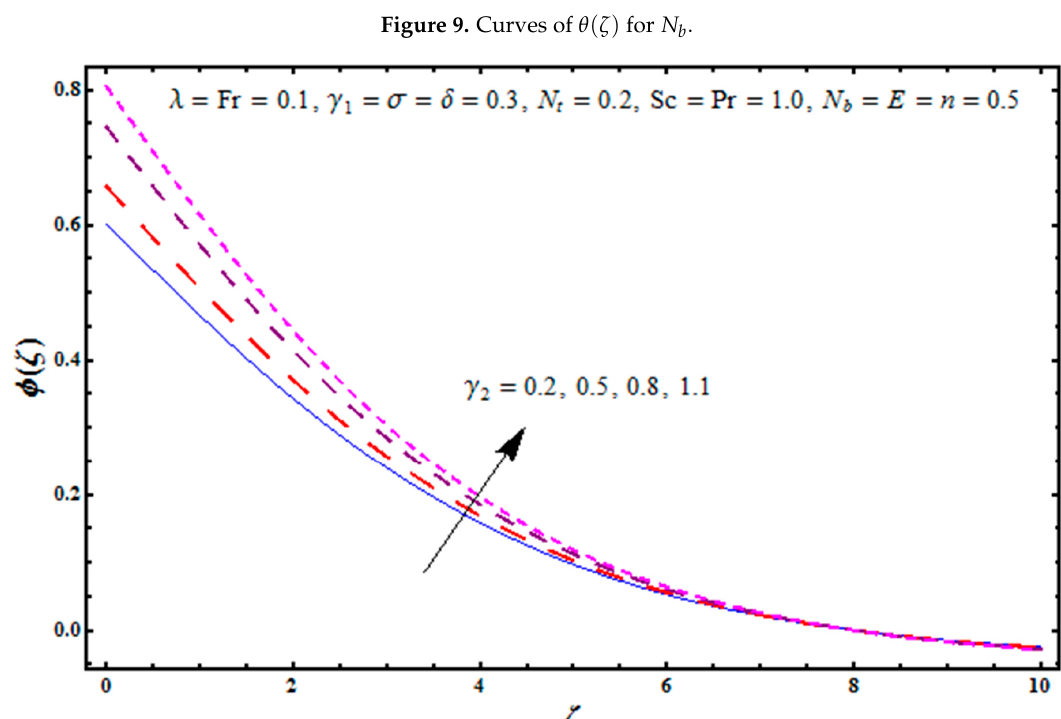
Figure 10. Curves of φ ( ζ ) for γ 2